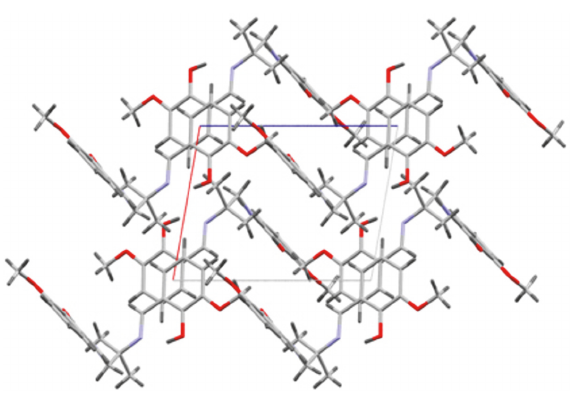
Figure 6: View along the 𝑏 -axis for H 2 L 2